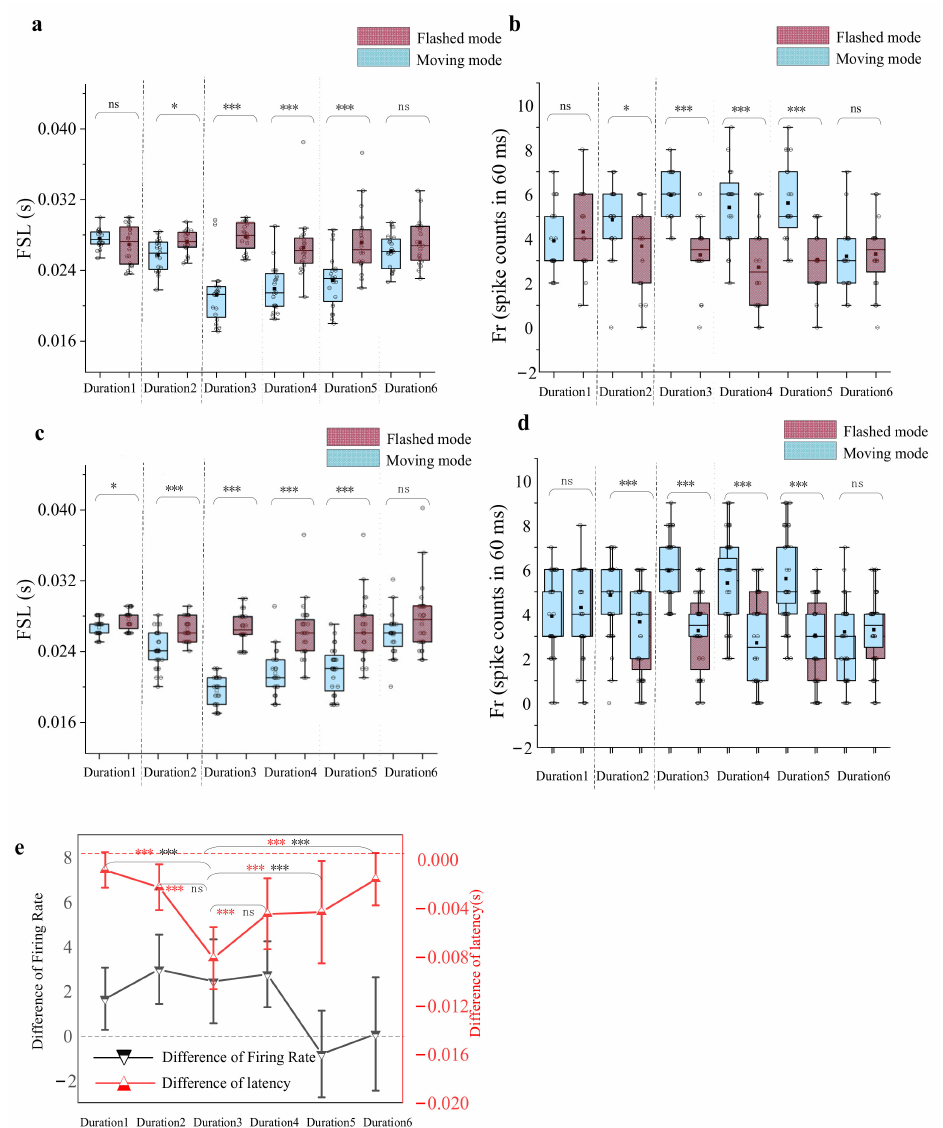
Figure 8. Results of varied stimulus durations. ( a , b ) The example results of the first spike latency and firing rates derived from two paradigms under varied duration paradigms for 20 repetitions (stimulus duration was set to 20 ms and moving direction was set to right). From left to right, the stimulus durations were 10 ms, 20 ms, 30 ms, 40 ms, 50 ms and 60 ms. The ‘ns’ indicates no significant difference between two groups of data (Bonferroni corrected, Wilcoxon rank-sum test, p > 0.05). ‘*’ indicates a weak difference between two groups of data (Bonferroni corrected, Wilcoxon rank-sum test, 0.01 < p < 0.05) and ‘***’ indicates a significant difference between two groups of data (Bonferroni corrected, Wilcoxon rank-sum test, p < 0.001). ( c , d ) A statistical result of 28 recording units. The boxplot graphs for first spike latency and firing rates derived from varied duration paradigms. ( e ) Mean difference in first spike latency and firing rates (flash latency minus motion latency) varied stimulus duration. All data represented mean (triangular symbols) and standard error (error bars), and dotted reference lines represent zero. Red asterisks indicated the levels of significance obtained from the mean difference in FSL. Black asterisks indicated the levels of significance obtained from the mean difference in